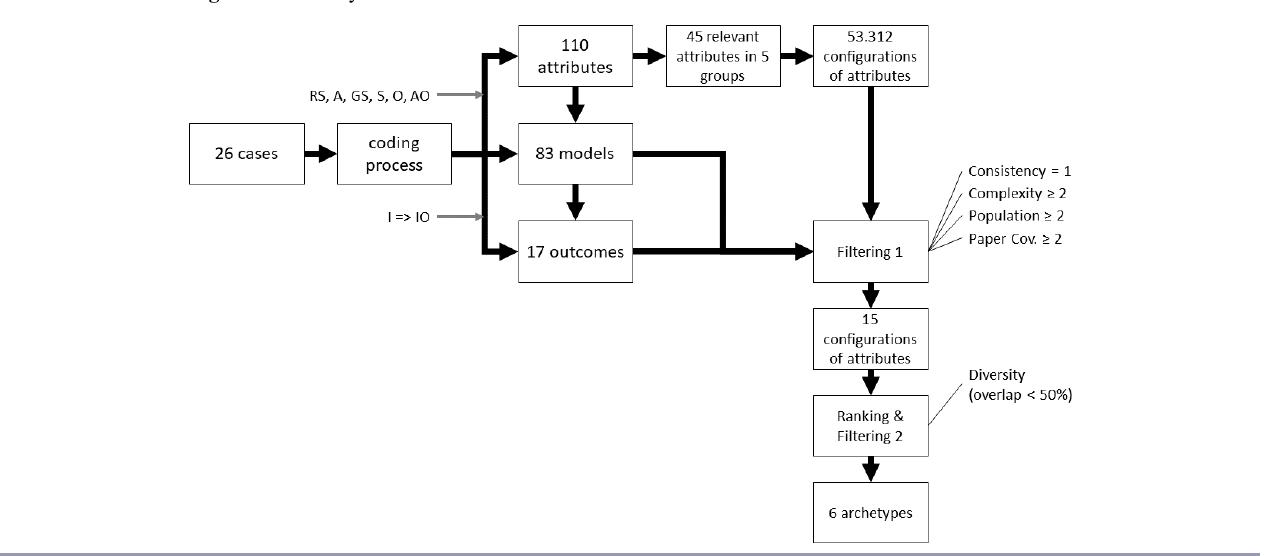
Fig. 1 . Data analysis